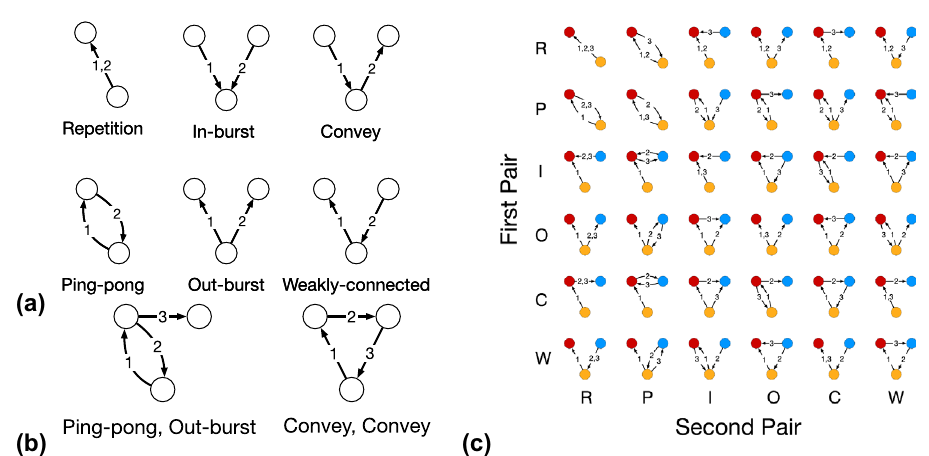
Figure 2. ( a ) All 2-event motifs, which are time-ordered event pairs. ( b ) Two examples of 3-event motifs labeled by the sequence of two 2-event pairs. ( c ) All 2-node 3-event and 3-node 3-event motifs. R stands for repetition, P for ping-pong, I for in-burst, O for out-burst, C for convey, and W for